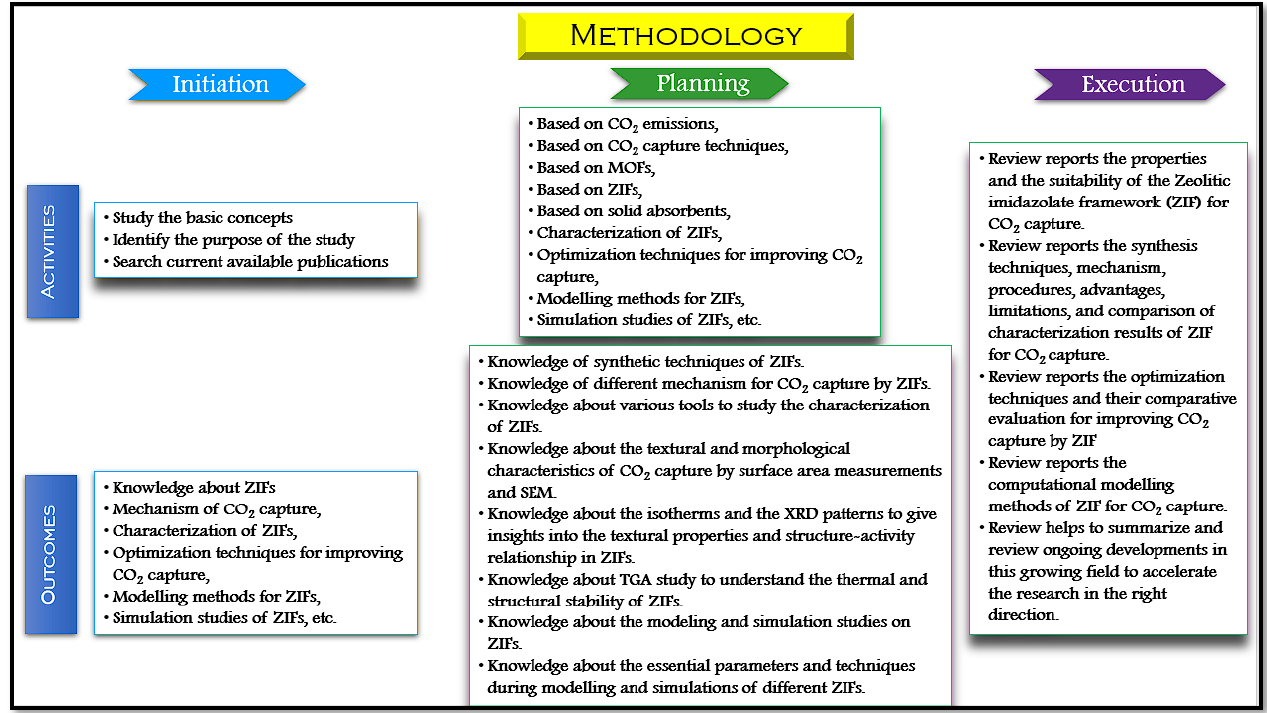
Figure 3. The methodology and strategy for review